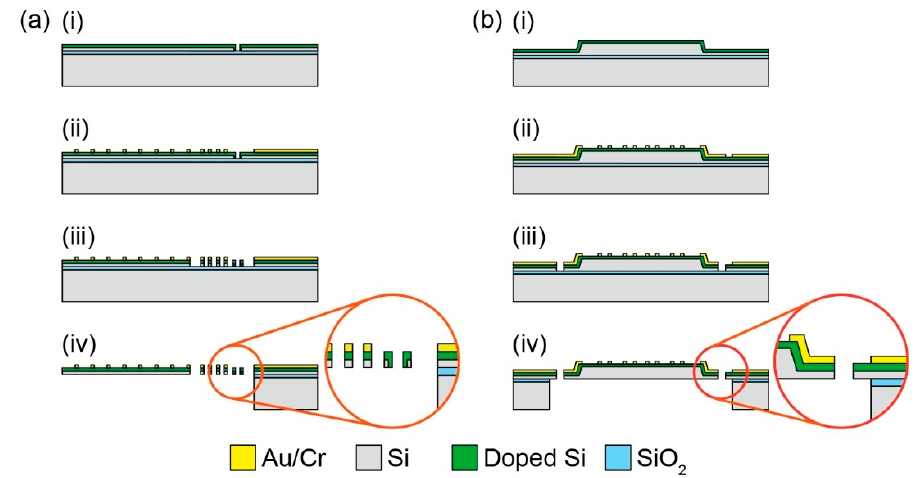
Figure 3. Fabrication process of ( a ) the biaxial MEMS force plate array for an ant [25] and ( b ) uniaxial MEMS force plate for a fruit fly [26]. ( a - i ) Doping holes are etched on the device Si layer by DRIE. A piezoresistor layer is formed on both sidewall of the etched holes and device Si surface with rapid thermal diffusion. ( a - ii ) Cr/Au layers are patterned on the doped Si layer. ( a - iii ) The device Si layer is etched by DRIE. ( a - iv ) The handle Si layer is etched by DRIE from the backside. The plate is released by etching the SiO 2 layer with HF vapor. ( b - i ) Mesa structure is formed by wet etching using tetra-methylammonium hydroxide (TMAH) solution. A piezoresistor layer is formed on the device Si surface by rapid thermal diffusion. ( b - ii ) Cr/Au layers are deposited and patterned on the doped Si layer. ( b - iii ) The device Si layer is etched by DRIE. ( b - iv ) The handle Si and SiO 2 layers are etched by DRIE and HF vapor,